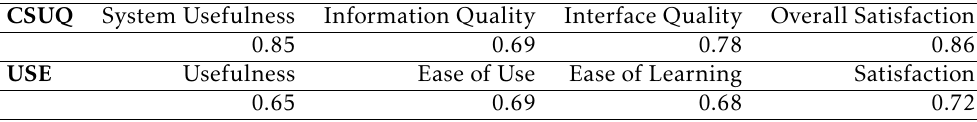
Table 1. Scores of the CSUQ (top) and USE (bottom)